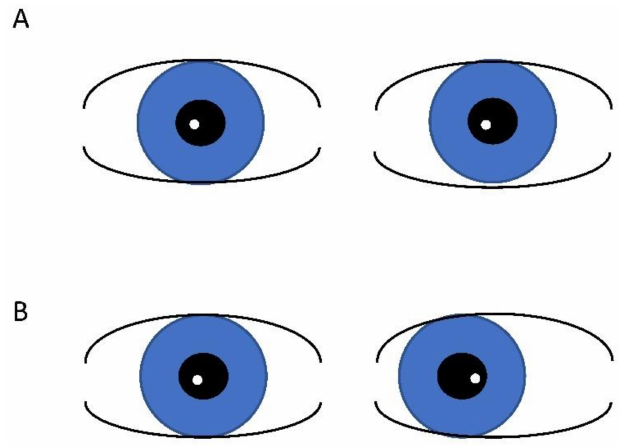
Figure 1. Hirschberg test demonstrating light reflex in same location in aligned (orthophoric) eyes ( A ) and temporal displacement of the light reflex in esotropia ( B